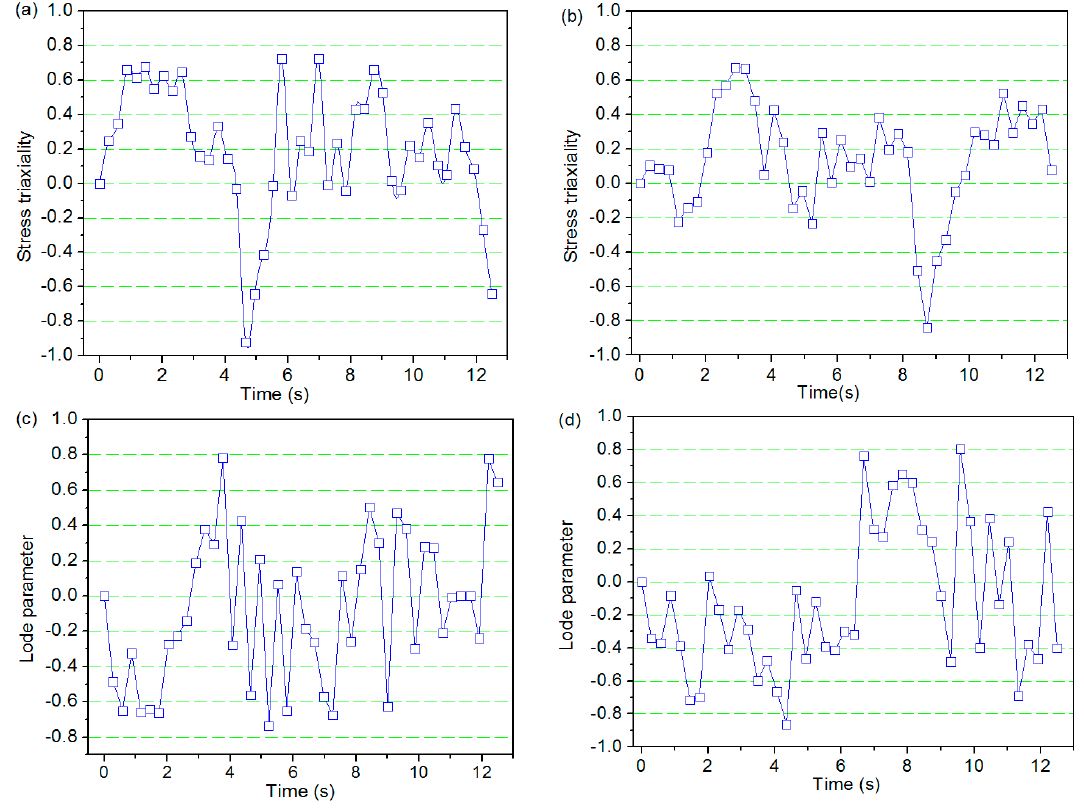
Figure 10. Distributions of stress triaxiality of the point ( a ) without crack; ( b ) with crack and lode parameter of the point ( c ) without crack and ( d ) with crack in forward tube spinning.